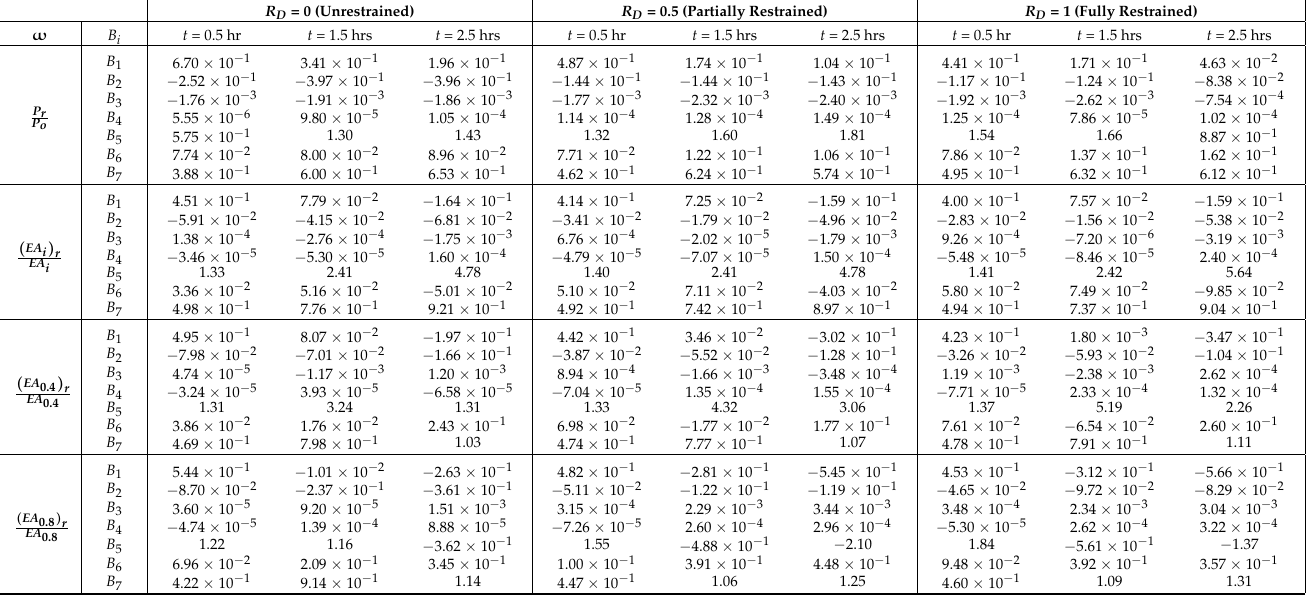
Figure 16. Validation of the proposed Equations (4) and (5) for residual axial stiffness. Table 3. Coefficient of Equation (5) for circular